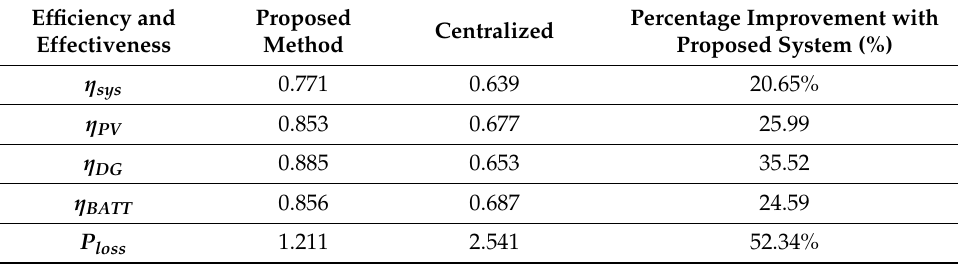
Figure 17. Improvement (%) by using proposed method. Table 3. Difference between with and without corrective